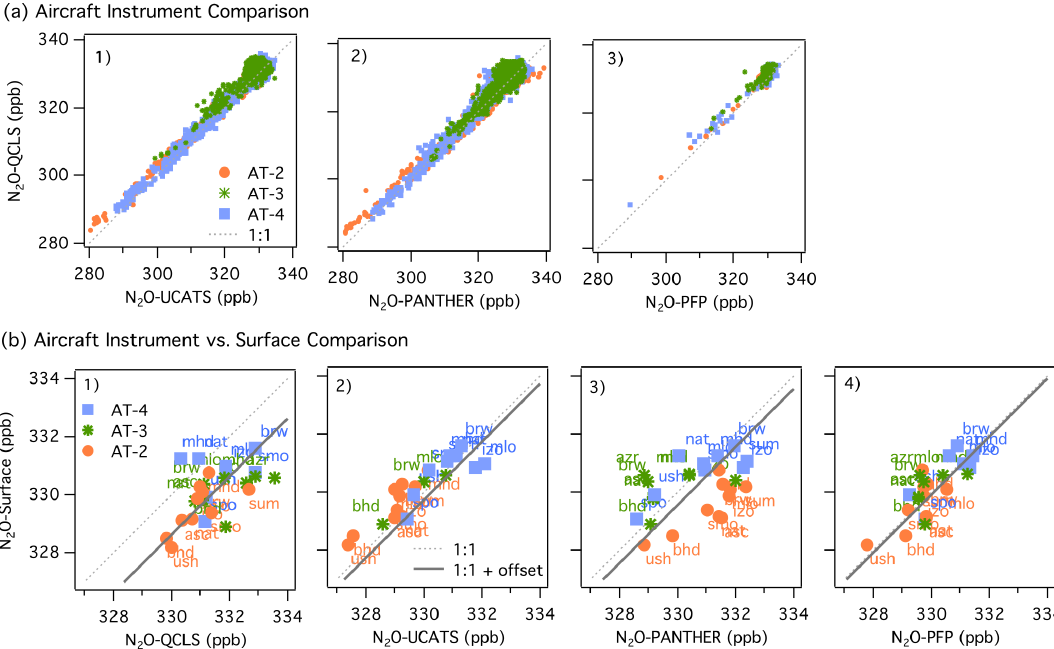
Figure 2. (a) Comparisons between Neptune-corrected QCLS N 2 O and (1) UCATS N 2 O, (2) PANTHER N 2 O, and (3) PFP N 2 O for ATom-2 (orange circles), ATom-3 (green stars), and ATom-4 (blue squares). We used the 10s averaged merged file to compare QCLS, UCATS, and PANTHER data. The PFP flask samples had longer sampling times (30s to a few minutes). The 1 : 1 line is shown as a dashed line. (b) Comparisons between NOAA N 2 O surface flask measurements and Neptune-corrected and airborne data from (1) QCLS N 2 O, (2) UCATS N 2 O, (3) PANTHER N 2 O, (4) and PFP N 2 O for ATom-2, -3, and -4, similar to ( a 1)–( a 3). The solid line shows the 1 : 1 relationship + offset. For plots ( b 1)–( b 4), the airborne data are the mean N 2 O values within ± 5 ◦ of latitude of each surface station and between 1 and